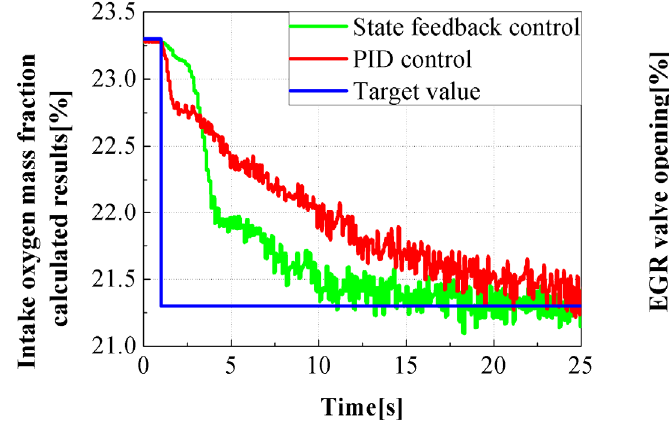
Figure 11. Comparison of the two kinds of control algorithm under constant speed loading conditions: ( a ) Intake oxygen mass fraction; ( b ) EGR valve opening; ( c ) NO x ; ( d ) intake oxygen volume fraction and intake oxygen mass fraction.